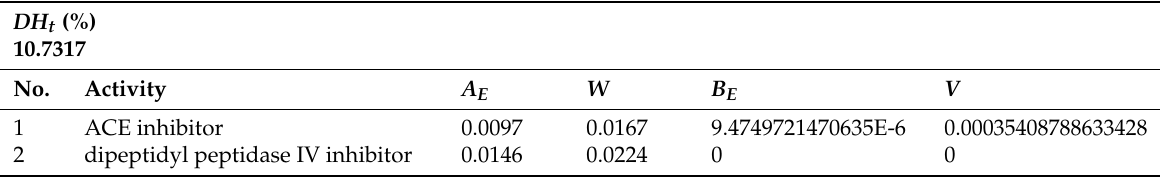
Table A40. A E , DH t , W , B E and V values from RubisCO of Halophila stipulacea . In silico enzymatic cleavage was carried out by using oligopeptidase